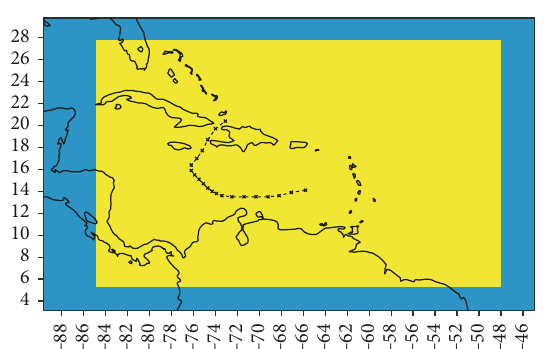
Figure 1: The parent (15km grid spacing) and inner (5 km grid spacing) domains used in the numerical experiments with WRF- ARW model are depicted in blue and yellow, respectively. The best track (i.e., the observed one) of Hurricane Tomas [9] for the period from 00UTC on 1 November to 00UTC on 6 November 2010 is represented by black